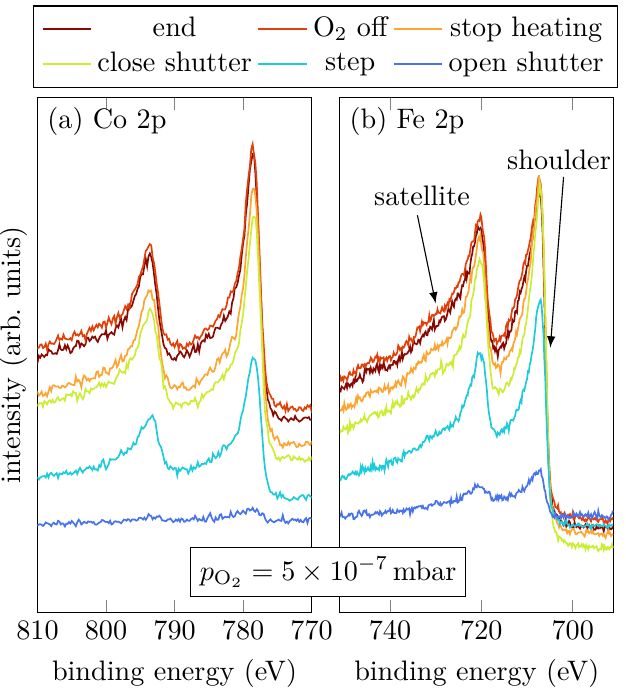
Figure 2. HAXPES spectra of sample A for characteristic events, as displayed, of the Fe 2p and Co 2p